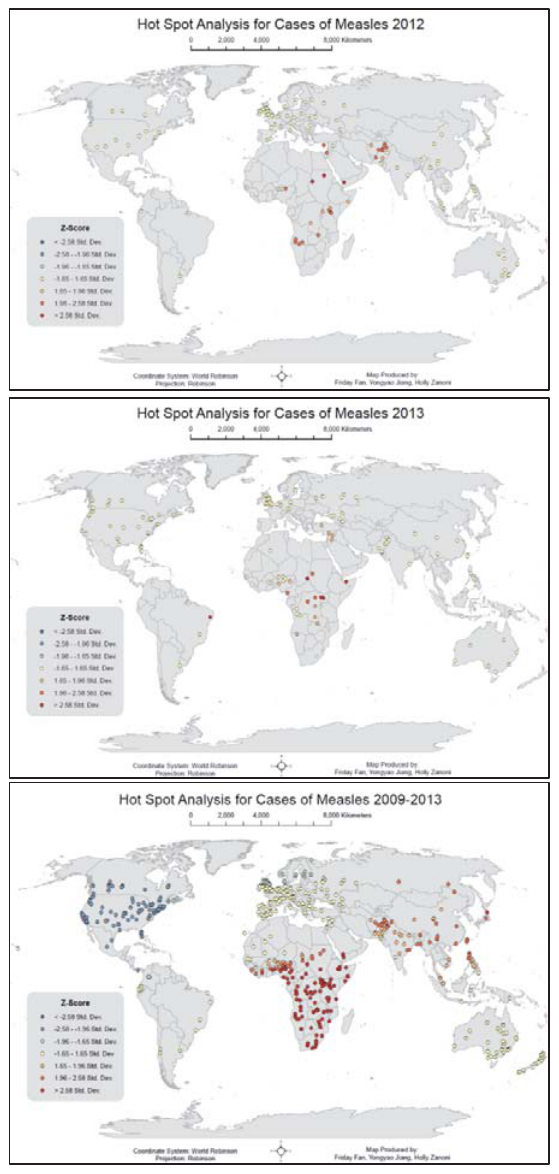
Figure 4. Hot spot analysis of measles